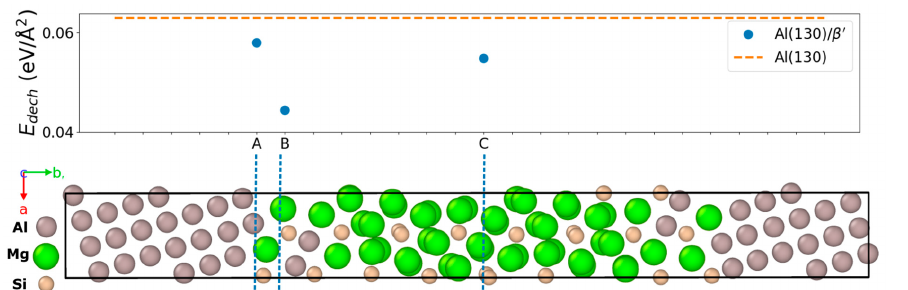
Figure 6. (Color online). Relaxed DFT model of the Al(130) interface constructed based on the TEM images, with possible decohesion interfaces and corresponding decohesion